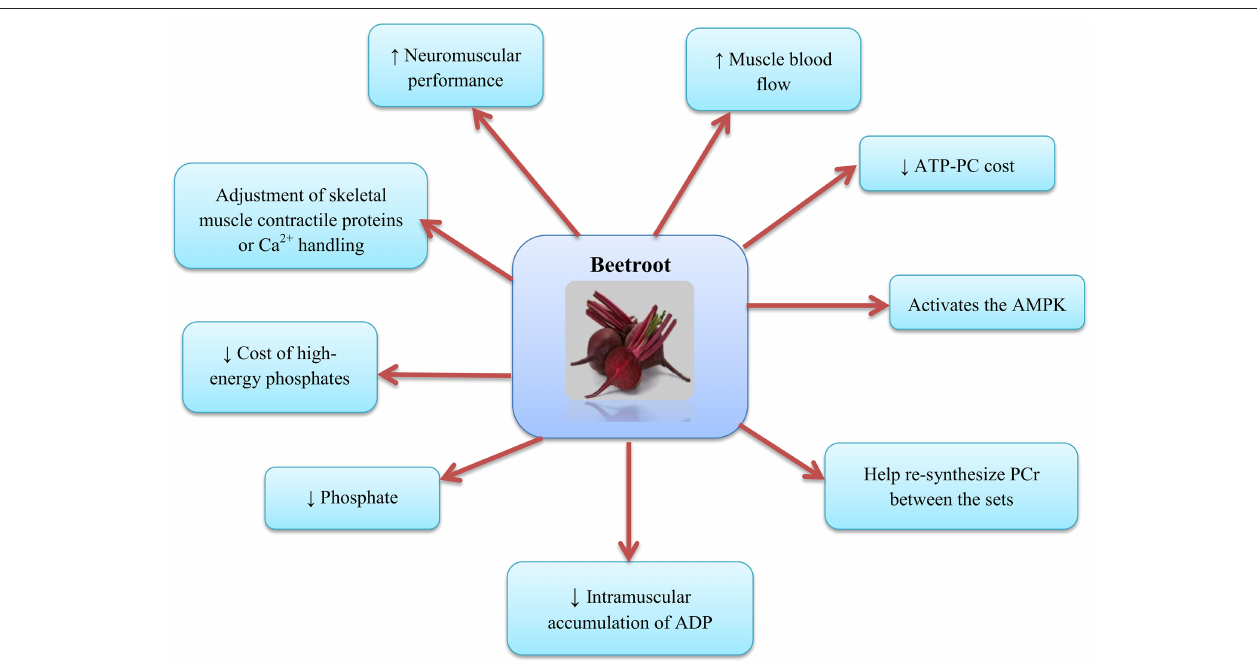
FIGURE 3 | Beetroot supplementation and the skeletal muscle. AMPK, AMP-activated protein kinase; PCr, Phosphocreatine; ADP, Adenosine